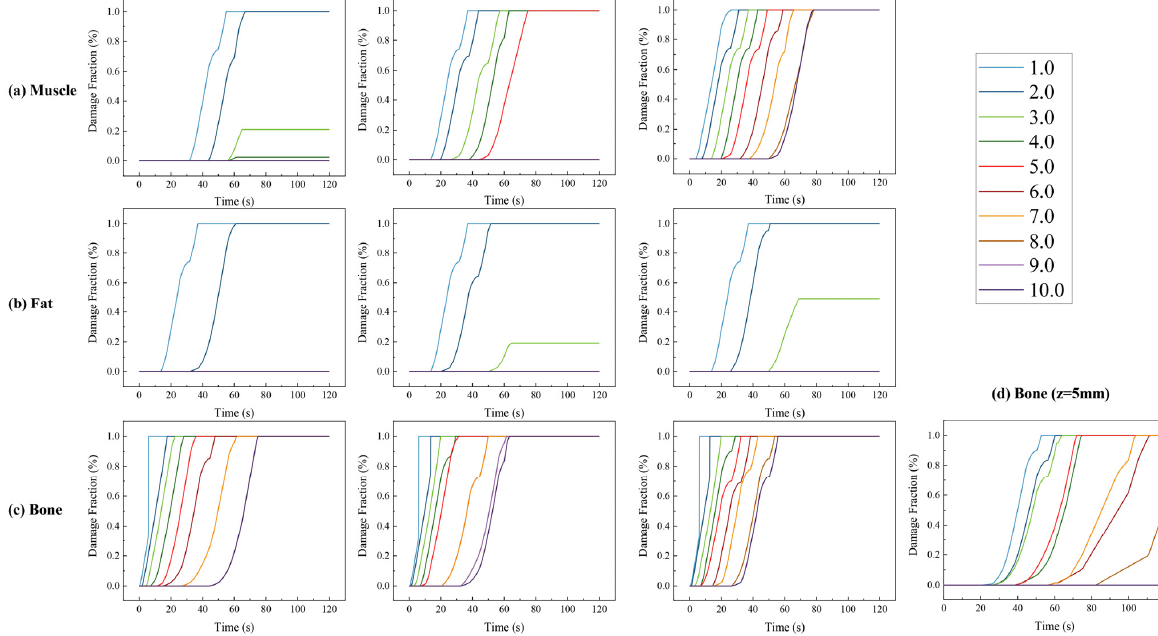
Figure 7. Damage fraction of three sequence points (z = 10 mm, z = 12 mm and z = 18 mm). All points recorded from 0 to 120 s are plotted. Bone damage fraction is additionally calculated at z = 5 mm. ( a ) Damage fraction from muscle; ( b ) Damage fraction from fat; ( c ) Damage fraction from bone.